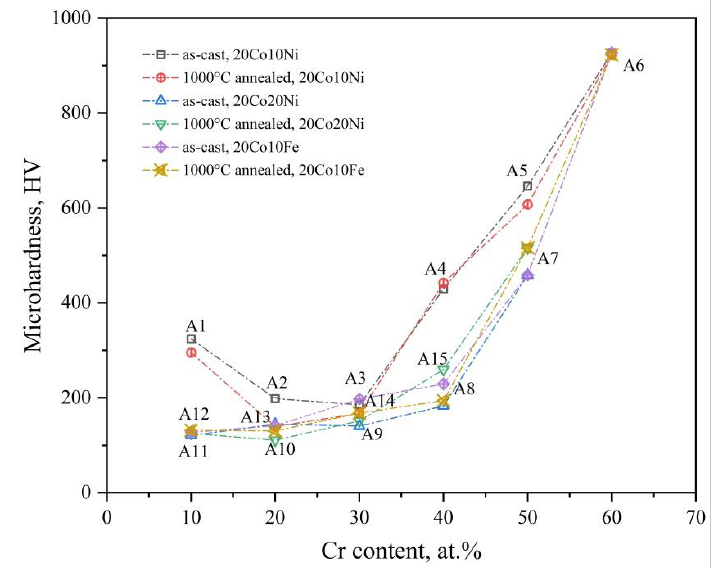
Figure 10. The micro-hardness of the 20Co-Cr-Fe-Ni alloys in as-cast and 1000 °C annealed states. The Fe-rich alloy A1 transforms from FCC to BCC during cooling and leads to higher microhardness.